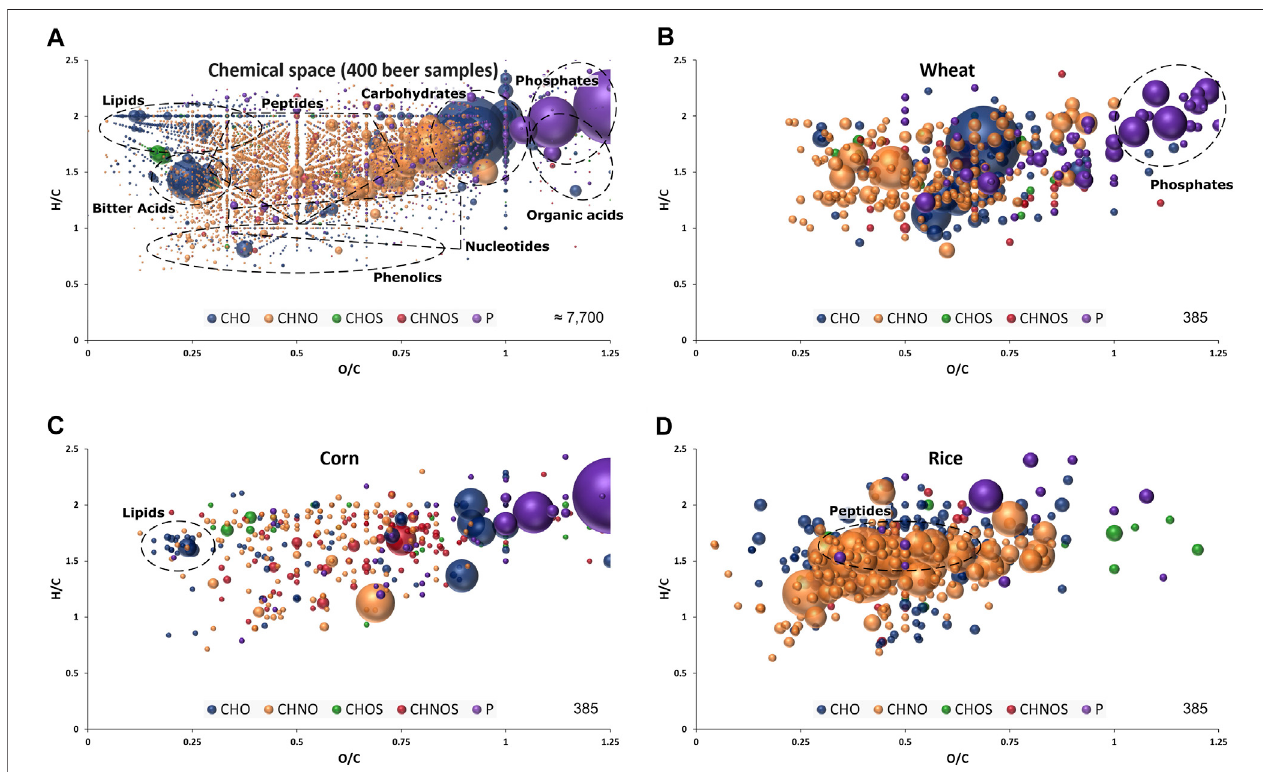
FIGURE1| VanKrevelen diagramofmolecularformula annotationsfound in400beer samples (A) and signi fi cantforwheat (B) ,corn (C) and rice (D) byFI-FTICR- MS as extracted after OPLS-DA modelling presented in Figure 2 . Regions speci fi c tocertain compound classes are highlighted. Color code: CHO blue; CHNO orange; CHOS green; CHNOS red; P purple. Neutral molecular formulae are plotted. The bubble size indicates the mean relative intensities of corresponding peaks in the